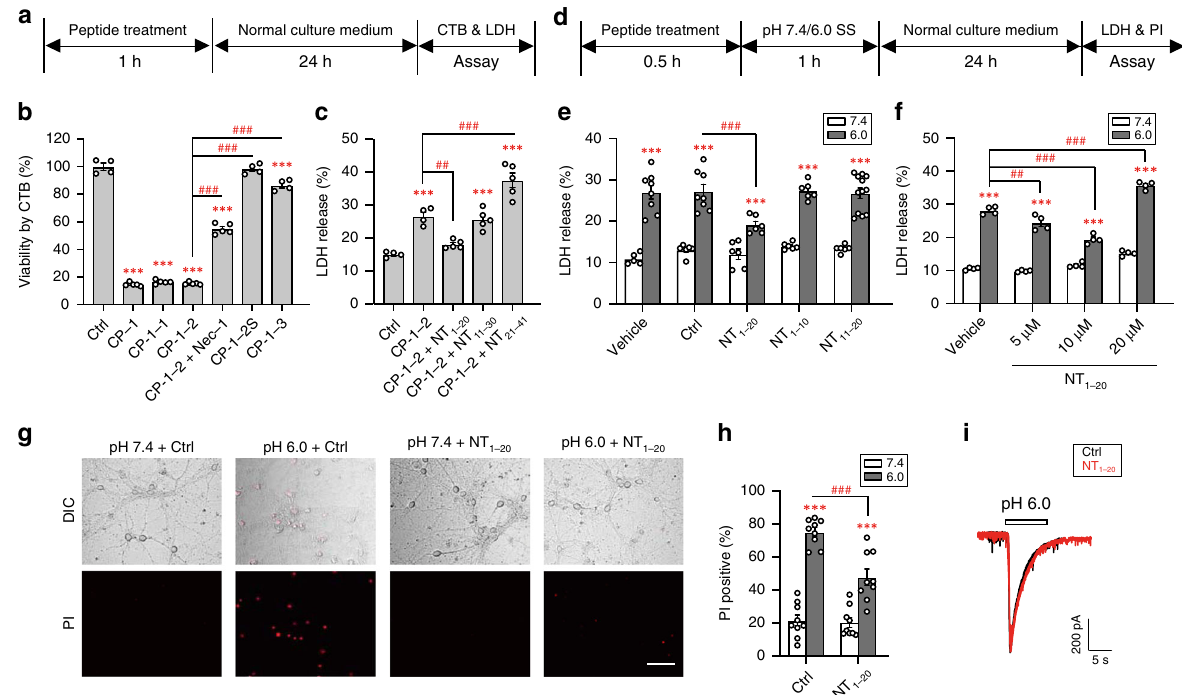
Fig. 1 Peptide NT 1 – 20 protects mouse cortical neurons against acidosis-induced necroptosis. a Schematics of cell death assays for ( b , c ). CTB, cell titer blue; LDH, lactate dehydrogenase. b CTB assay for viability of neurons treated with indicated peptides (all at 10 μ M). CP-1, CP-1-1, CP-1-2 and CP-1-3 reduced viability. Nec-1 (20 μ M) attenuated CP-1-2 induced death. Compared to CP-1-2, CP-1-3 induced much less and the membrane impermeable CP-1- 2S induced no death. n = 4 – 6, *** p < 0.001 vs . control peptide (Ctrl, TAT alone), ### p < 0.001 vs . CP-1-2, by ANOVA. c LDH release assay for viability of neurons treated with CP-1-2 (10 µ M) without or with NT peptides (10 µ M). The toxicity by CP-1-2 was signi fi cantly reduced by NT 1 – 20 , but not NT 11 – 30 and NT 21 – 41 . n = 4 – 5, *** p < 0.001 vs . Ctrl, ## p < 0.01, ### p < 0.001 vs . CP-1-2, by ANOVA. d Schematics of cell death assay for ( e – h ). PI, propidium iodide (PI); SS, standard extracellular solution. e LDH release from neurons exposed to pH 7.4 and pH 6.0 SS. pH 6.0-induced death was reduced by treatment of 10 µ M NT 1 – 20 , but not NT 1 – 10 and NT 11 – 20 . n = 5 – 12, *** p < 0.001 vs . corresponding pH 7.4, ### p < 0.001 vs . Ctrl in pH 6.0, by ANOVA. f Concentration dependence of NT 1 – 20 suppression of acidotoxicity. n = 4, *** p < 0.001 vs . corresponding pH 7.4, ## p < 0.01, ### p < 0.001 vs . vehicle in pH 6.0, by ANOVA. g DIC (upper) and PI staining (lower) images of neurons treated as in ( d ). Scale bar, 50 µ m. h Summary for ( g ). n > 200 neurons counted for each. *** p < 0.001 vs . corresponding pH 7.4, ### p < 0.001 vs . Ctrl in pH 6.0, by ANOVA. i Pretreatment (0.5 h) with 10 μ M NT 1 – 20 had no effects on pH 6.0-induced currents in cultured neurons. Representative current traces at − 60 mV are shown. Error bars are SEM for all summary